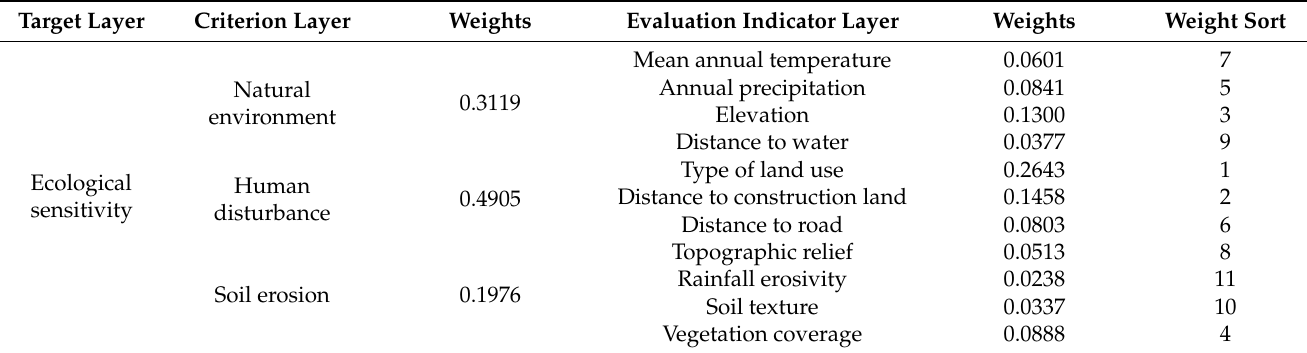
Table 3. Weigh of ecological sensitivity evaluation